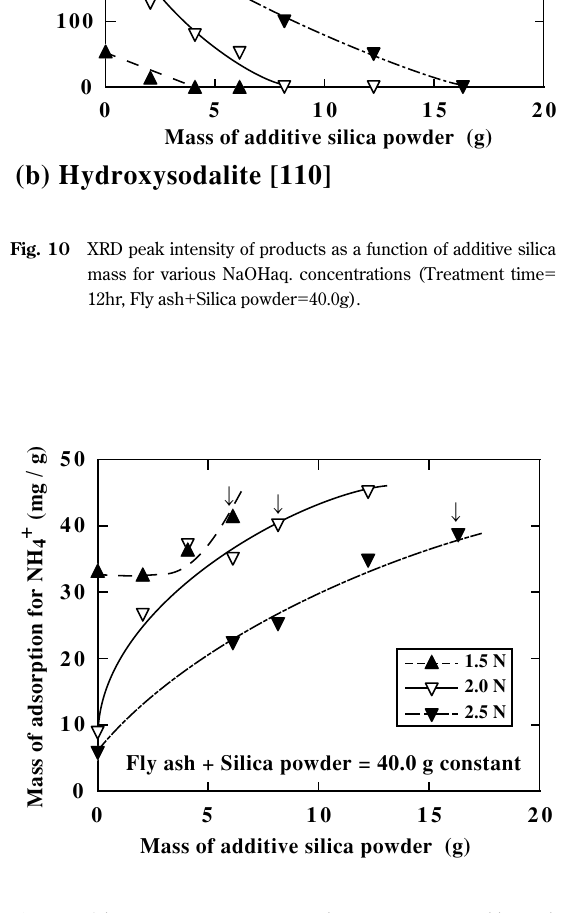
Fig. 11 Adsorption mass of NH 4 + for products as a function of additive sil- ica mass for various NaOHaq. concentrations (Treatment time = 12hr, Fly ash + Silica powder = 40.0g).